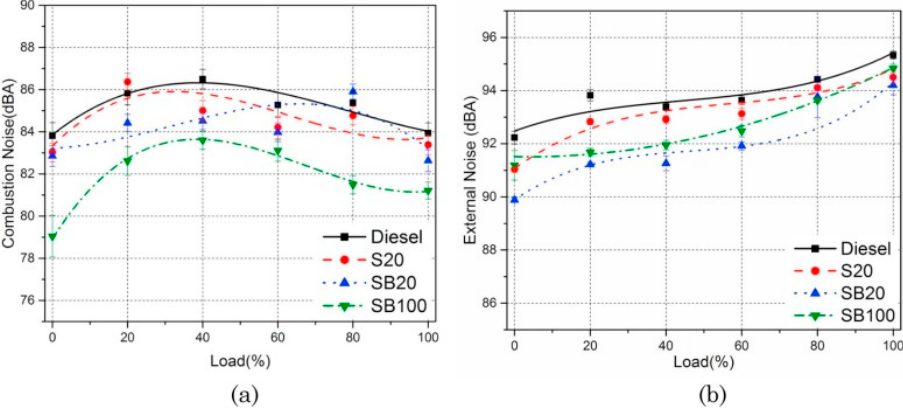
Figure 16. ( a ) Combustion noise and ( b ) engine external noise of different fuels [132].